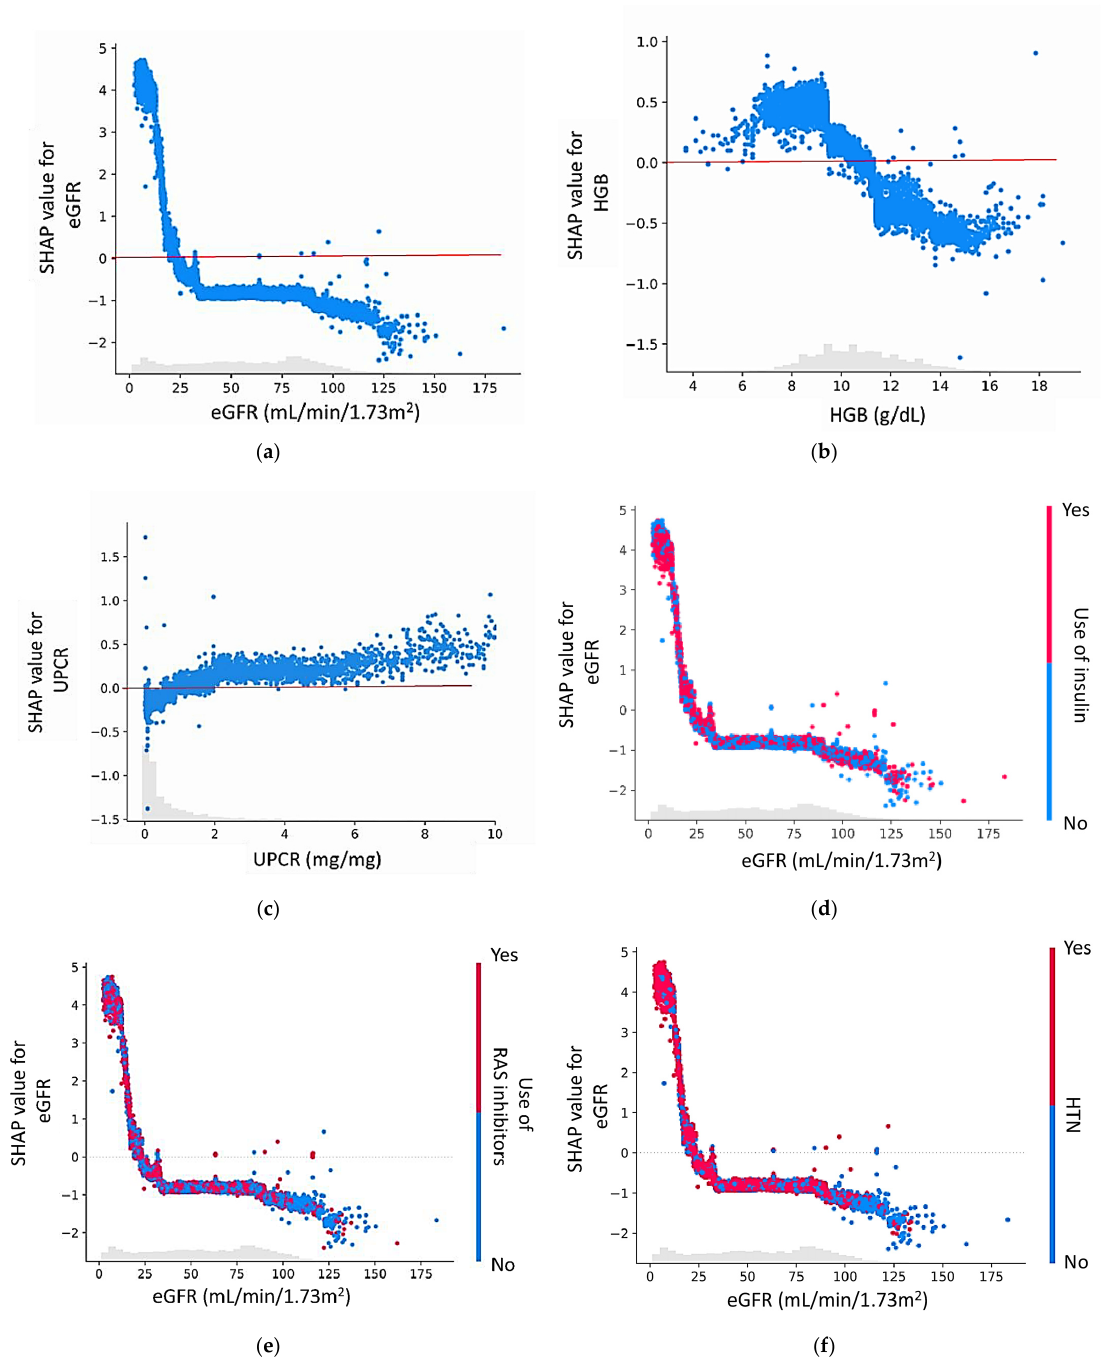
Figure 4. SHAP dependence plots of the GBDT model. Figure 4a–c showed the impact of eGFR ( a ), HGB ( b ), and UPCR ( c ) on the prediction model’s output. The risk prediction for end-stage renal disease development increases while the SHAP values of specific features exceed zero, represented by the red lines. Figure 4d–f showed the interaction effects between eGFR and the use of insulin ( d ), eGFR and the use of RAS inhibitor ( e ), eGFR and HTN ( f ) in the prediction model. The dotted lines represent while the SHAP value is zero. Abbreviations: SHAP—Shapley additive explanation; eGFR—estimated glomerular filtration rates; HGB—hemoglobin; UPCR—urine protein/creatinine ratio; RAS—renin–angiotensin system; HTN—hypertension; GBDT—gradient boosting decision tree. Red/blue—Features that push the prediction higher are shown in red, and those pushing the prediction lower are blue. A gray area refers to the patient distribution by eGFR